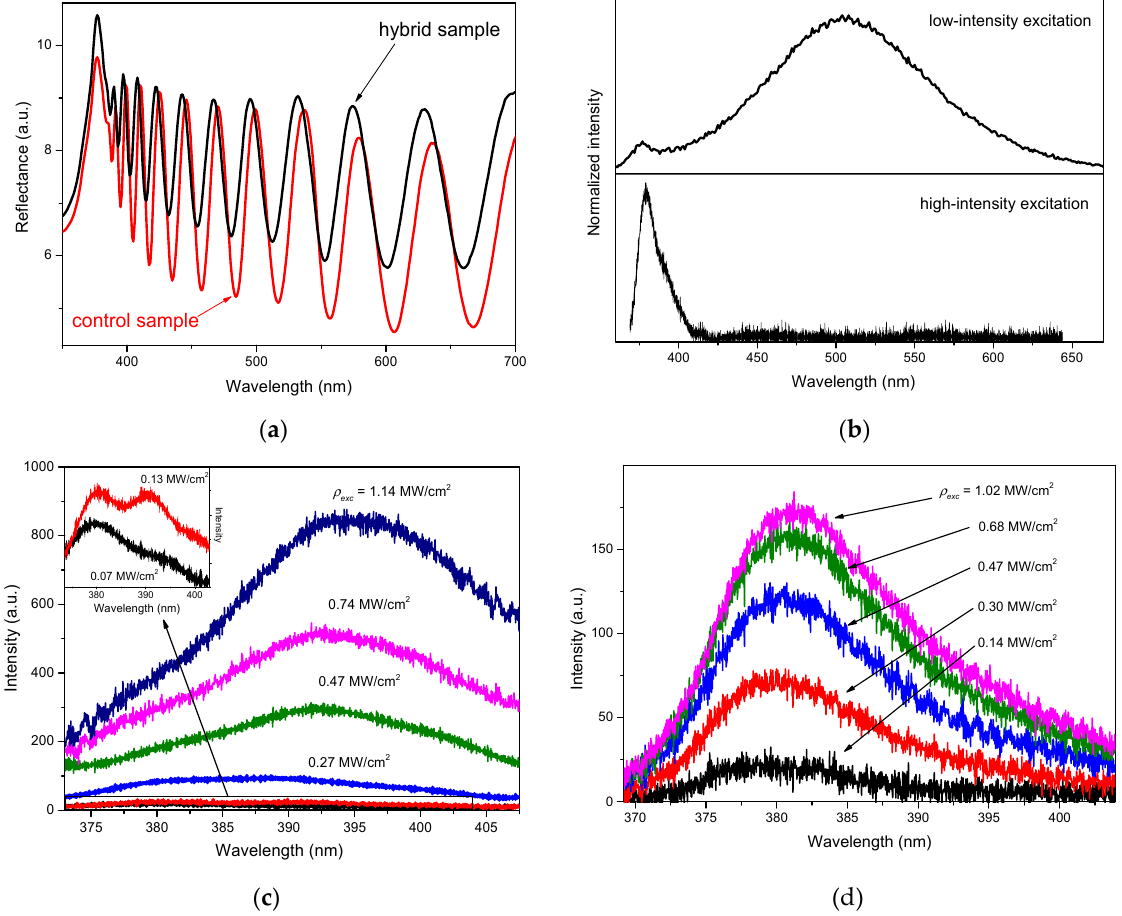
Figure 4. Optical and emission properties of the samples: ( a ) Directional reflectance spectra for the hybrid (black) and control (red) samples; ( b ) PL spectra of the hybrid sample at cw low-intensity (top) and pulsed high-intensity (bottom) excitations; ( c , d ) NBE emission spectra of the hybrid ( c ) and control ( d ) samples at different excitation power densities ρ exc .